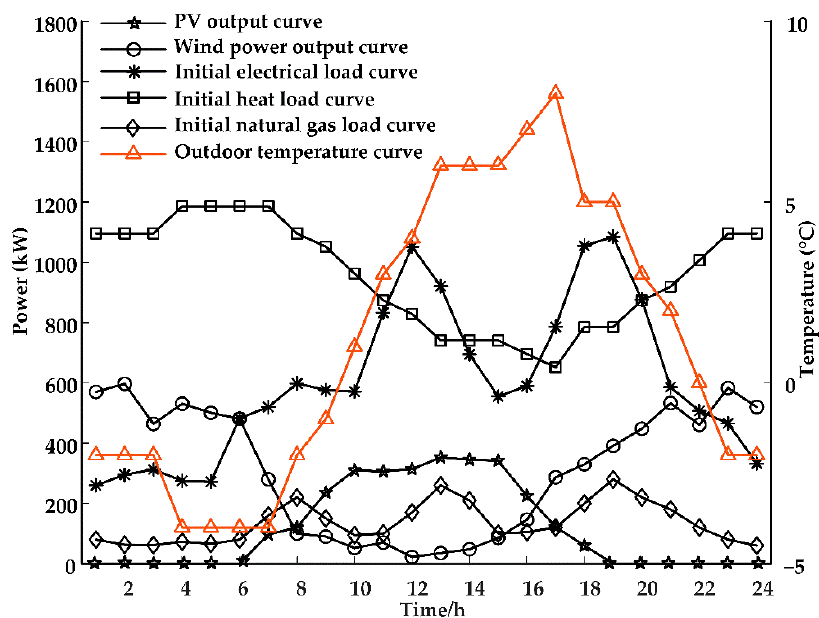
Figure 3. Forecasting curves of renewable energy output, initial load, and outdoor temperature.